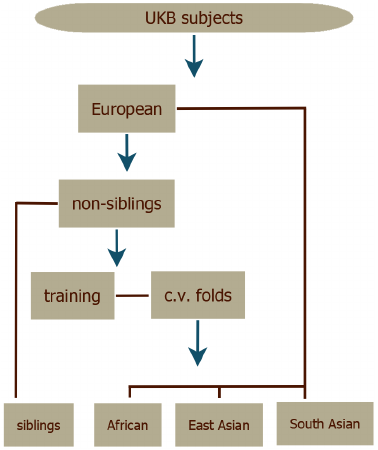
Figure 2. The dataset splits in the general training process. (1) European, African, East Asian, and South Asian ancestry groups are made from the UKB subject data. (2) The large European set is split into sibling and non-sibling sets. (3) The non-sibling set is further split into training sets and cross-validation (c.v.) folds. (4) Final predictors are tested on the remaining